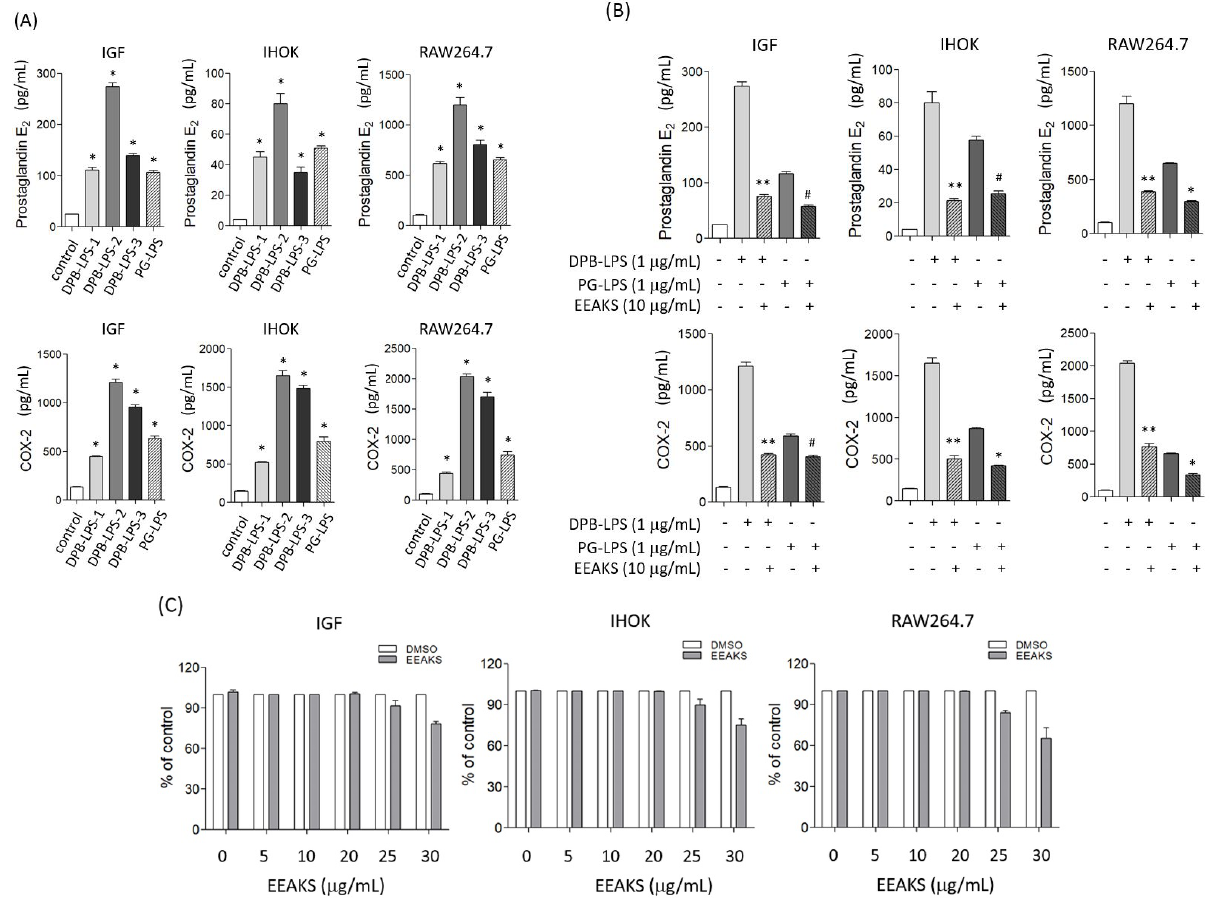
Figure 2. Effect of the EEAKSs on dental plaque bacterial-LPS-induced prostaglandin E 2 and cy- cyclooxygenase-2. ( A ) The effect of bacterial LPS on PGE 2 and COX-2 levels in immortalized